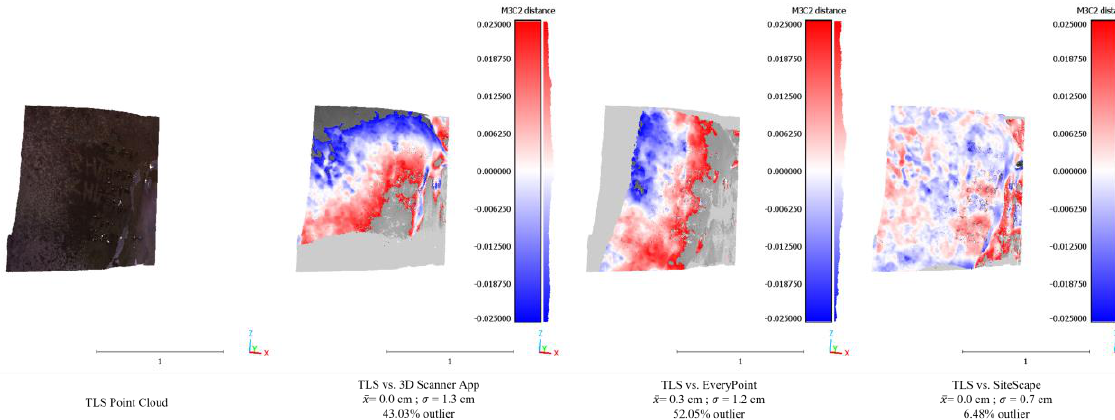
Figure 3. The comparison in case (3) is between TLS and iPad LiDAR using M3C2 analysis in Cloud Compare. The gray area represents an outlier.